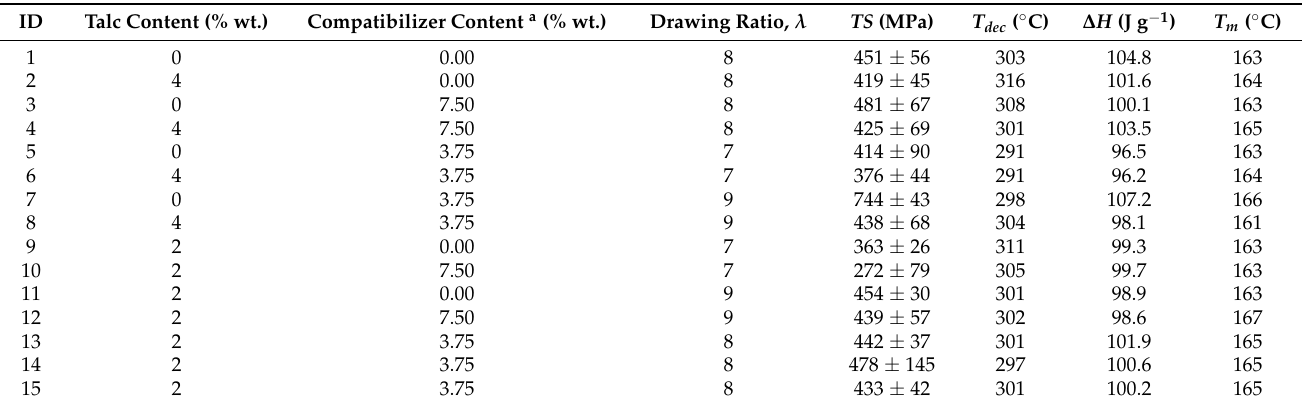
Table 4. DoE1 results (composites with